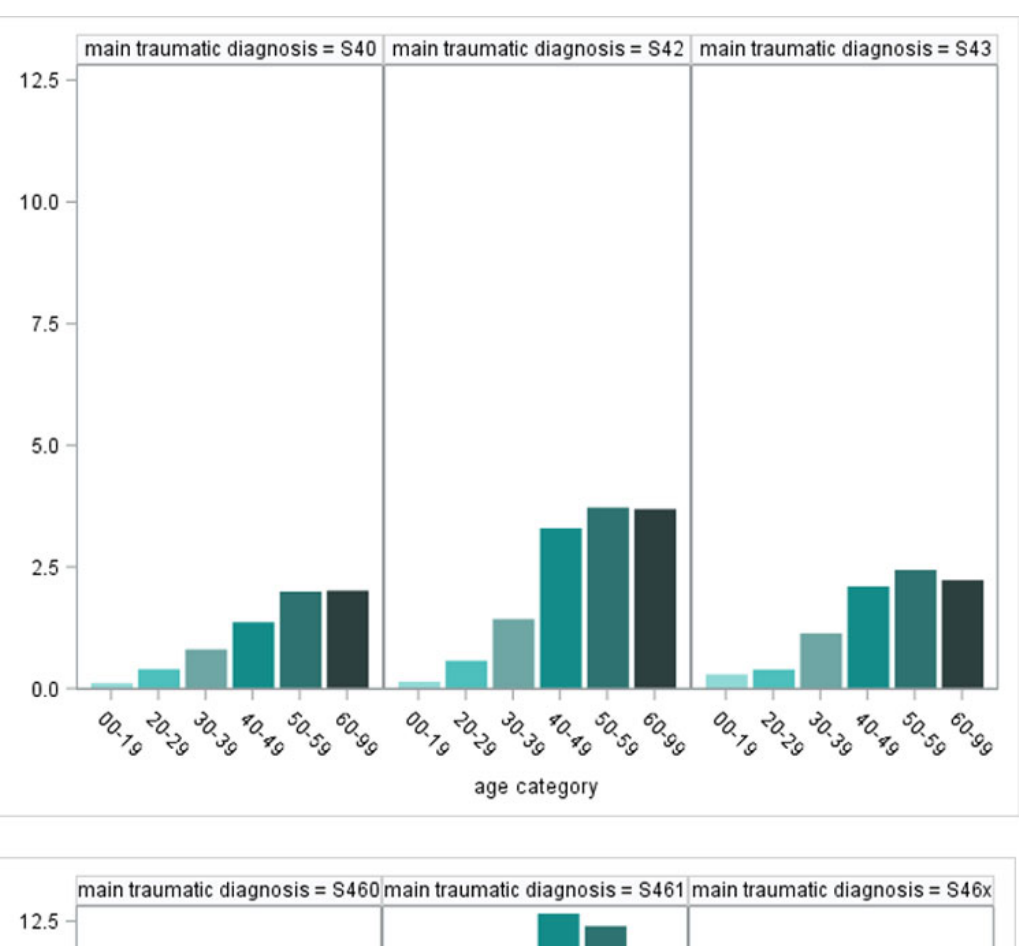
Figure S1: Percentage of cases developing frozen shoulder by diagnosis group and age